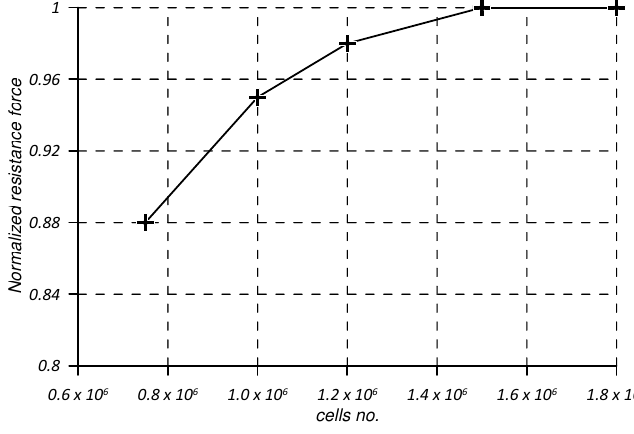
Figure 6. Grid sensitivity.